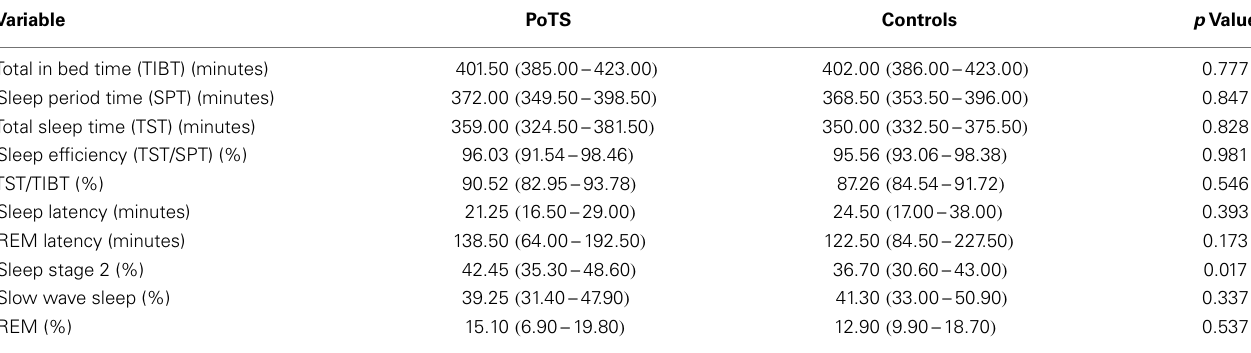
Table 2 | Parameters of sleep efficiency and sleep architecture presented in median with its interquartile range .